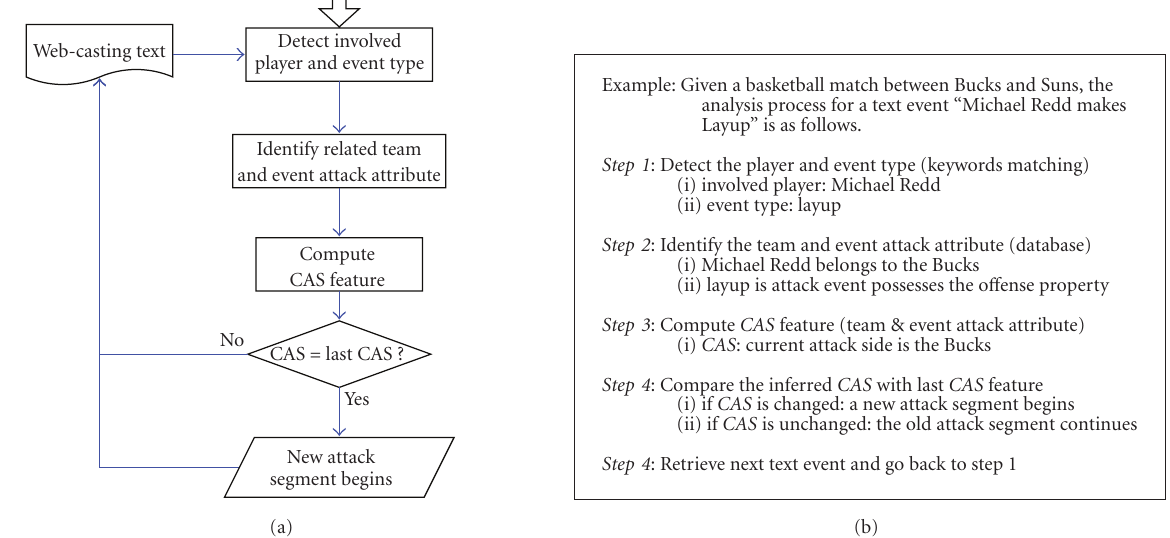
Layup” is as follows.